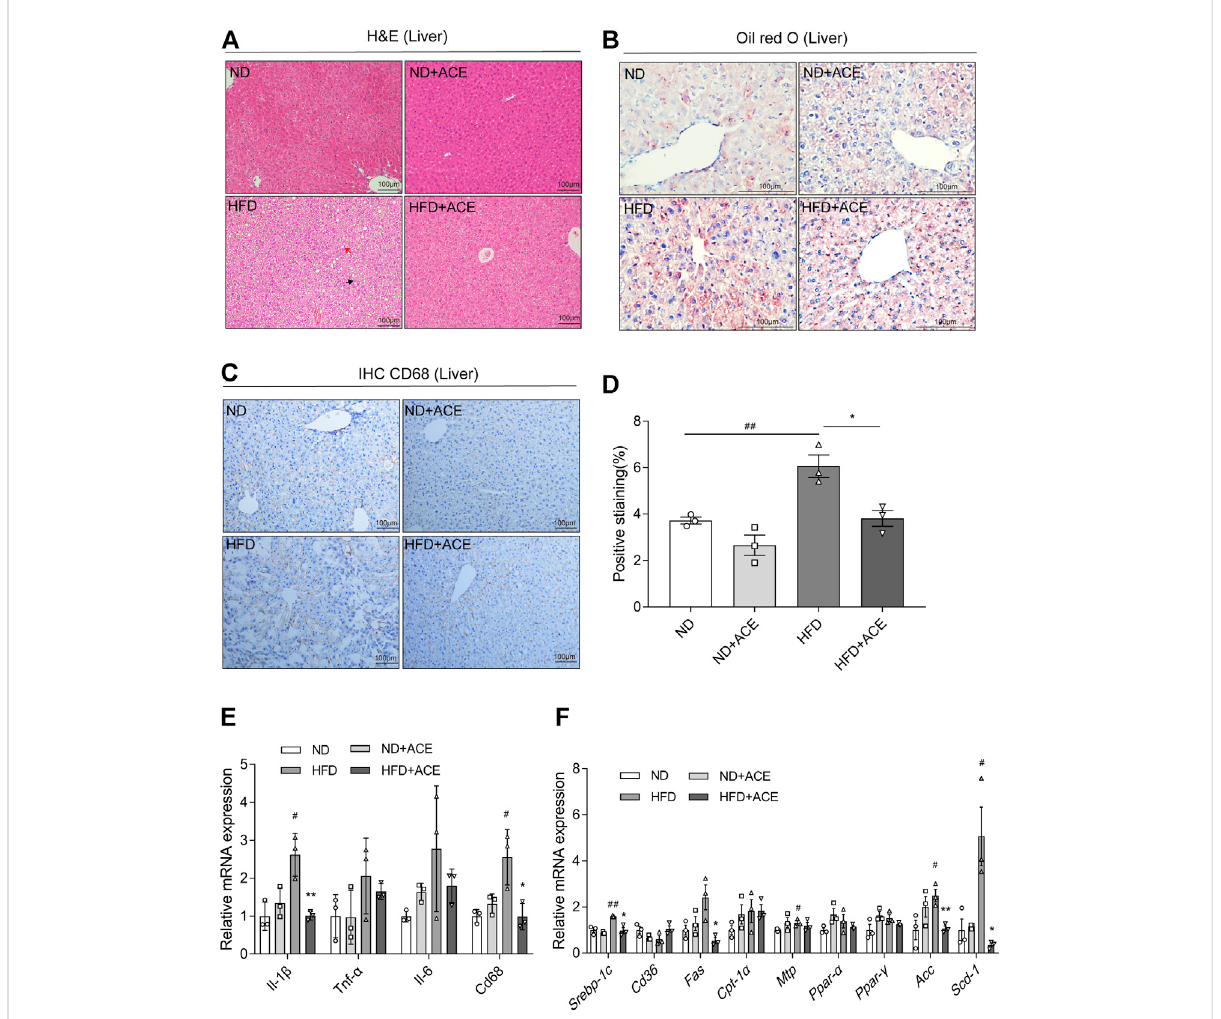
FIGURE 4 ACE alleviated HFD-induced liver injury. (A) Representative pictures of Hematoxylin and Eosin (H&E) staining for liver tissue. Black arrow indicatesballooninghepatocytes,redarrowindicatessteatosisinliver.Pictureswereshownas20×zoom,scale:100 μ m. (B) Representativepictures ofOilRed O staining for liverfat. Pictureswereshown as 40 ×zoom, scale: 100 μ m. (C) Representative pictures ofCD68 expression and distribution in liver tissues. Pictures were shown as 20 × zoom, scale: 100 μ m. (D) Quanti fi cation of CD68 expression in liver tissues. (E) Relative expression of Il-1 β , Il-6 , Tnf- α , Cd68 in liver. (F) Relative expression of srebp-1c , Cd36 , Fas , Cpt-1 α , Mtp , Ppar- α , Ppar- γ , Acc , Scd-1 in liver. Data were shown as means ± S.E.M (n = 3 per group). Statistical analysis was conducted by using ANOVA or independent student- t test. # denotes p < 0.05 when compared with the ND group, ## denotes p < 0.01 when compared with the ND group; * denotes p < 0.05 when compared with the HFD group, ** denotes p < 0.01 when compared with the HFD